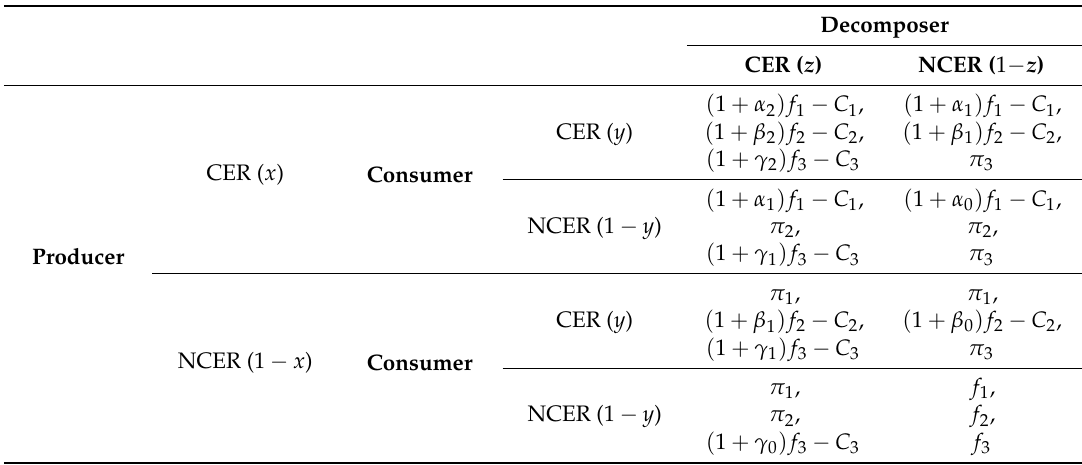
Table 1. The payoff matrix of the tripartite evolutionary